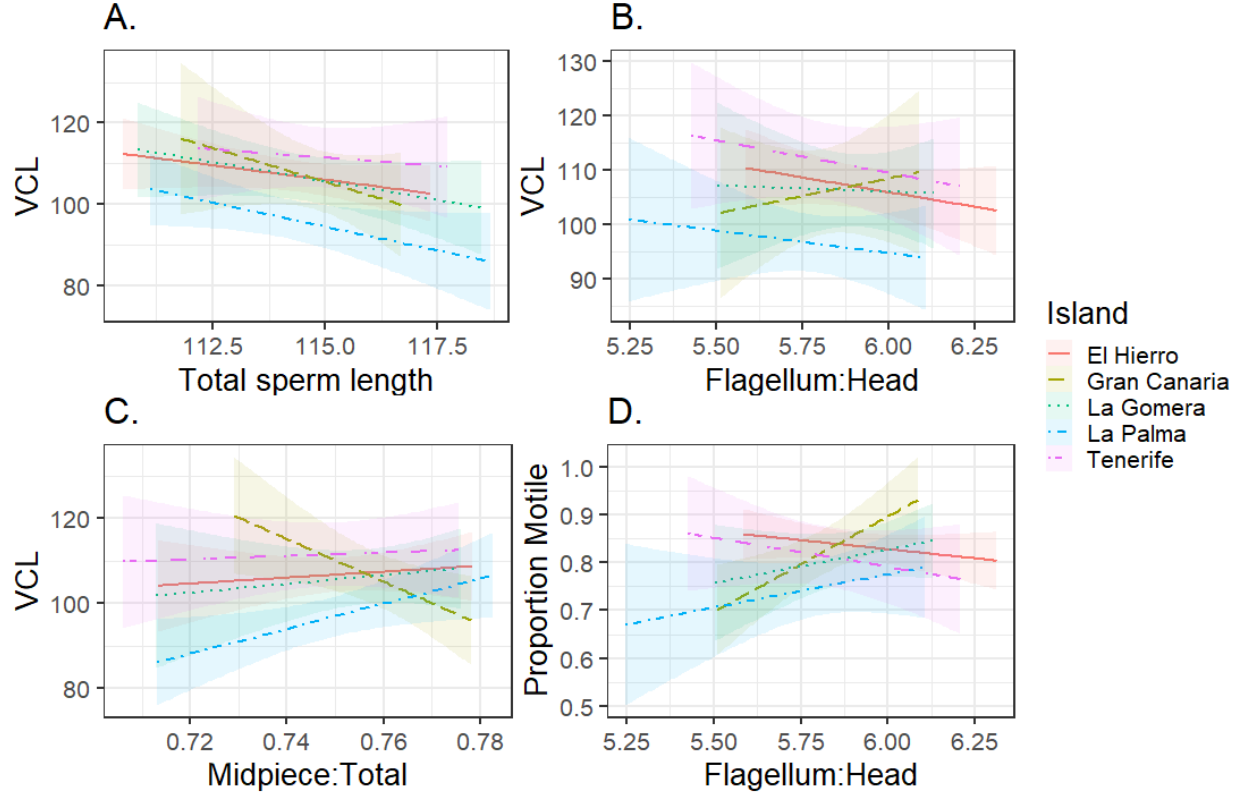
Figure 1. Relationship between sperm morphology and swimming performance for Canary Islands chiffchaffs. ( A ) Total sperm length (µm) versus sperm swimming speed, ( B ) flagellum:head ratio versus sperm swimming speed, ( C ) mid- piece:total sperm length ratio versus swimming speed, ( D ) flagellum:head ratio versus the proportion of motile cells. Average values per male are shown, though statistics used curvilinear velocity (VCL, µm/s) and motility data from indi- vidual cells. Islands of sampling: El Hierro: solid line, n = 21 males. Gran Canaria: dashed line, n = 13 males. La Gomera: dotted, n = 9 males. La Palma: dot, single dash, n = 22 males. Tenerife: dot, several dashes, n = 8 males.